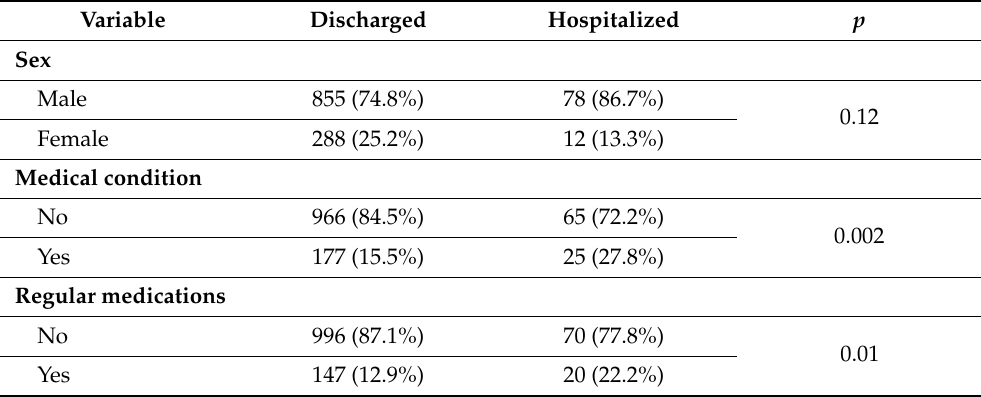
Table 3. Univariate tests of association of all variables with